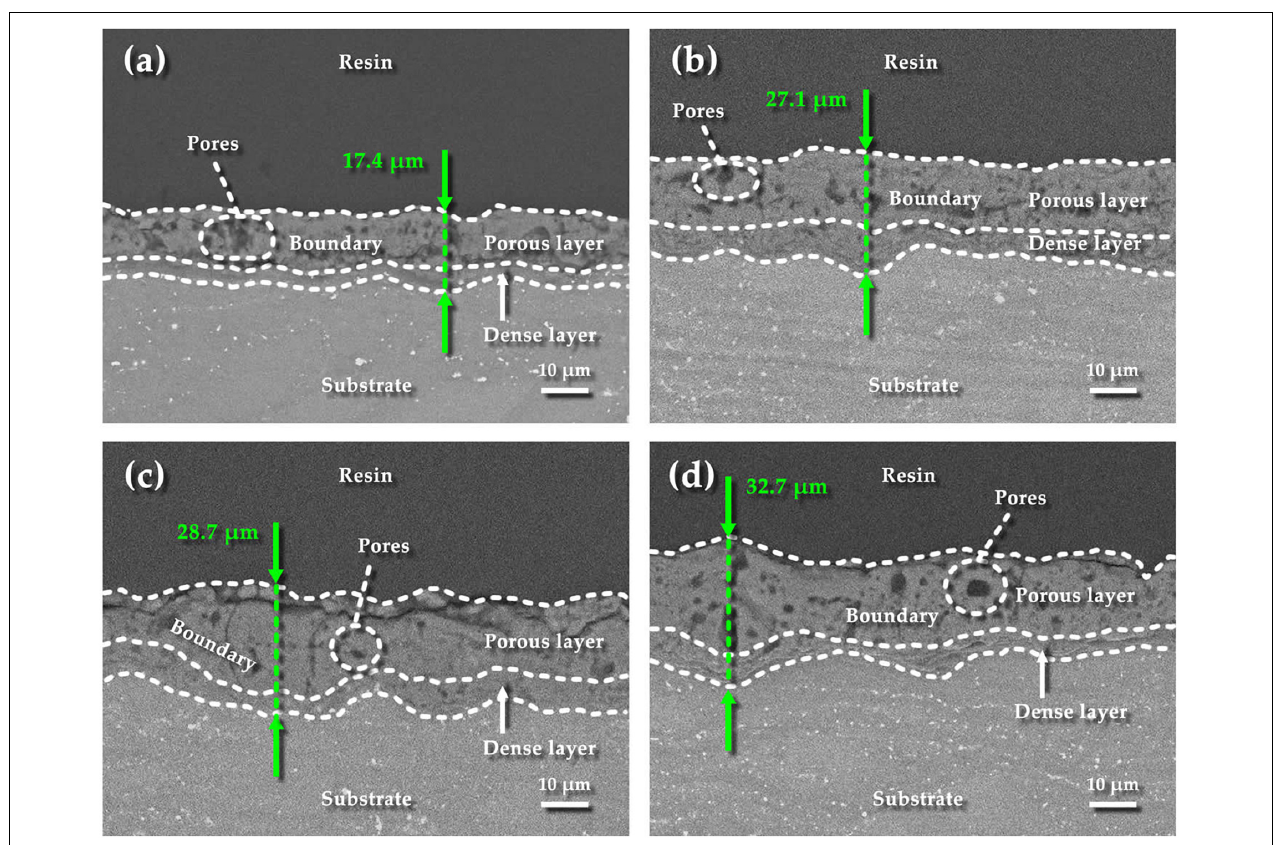
FIGURE 4 | Cross-sectional morphologies of the coatings under different current modes: (a) 1.2 A; (b) 1.2–0.6 A; (c) 1.2–0.8 A; (d) 1.2–1.0 A.